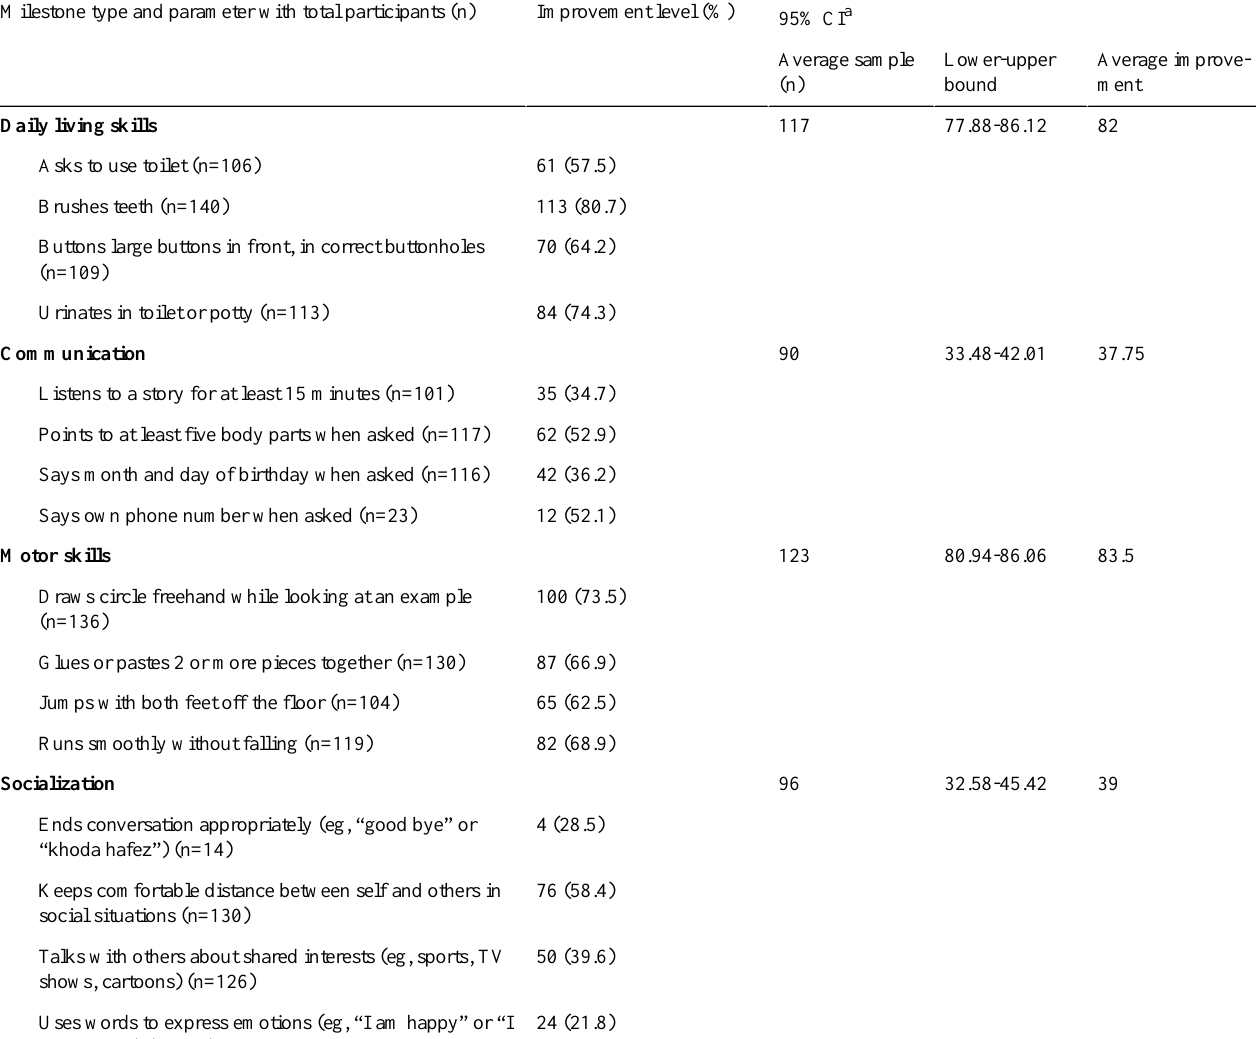
Table 3. Improvement level of the test group (mCARE) on their milestone